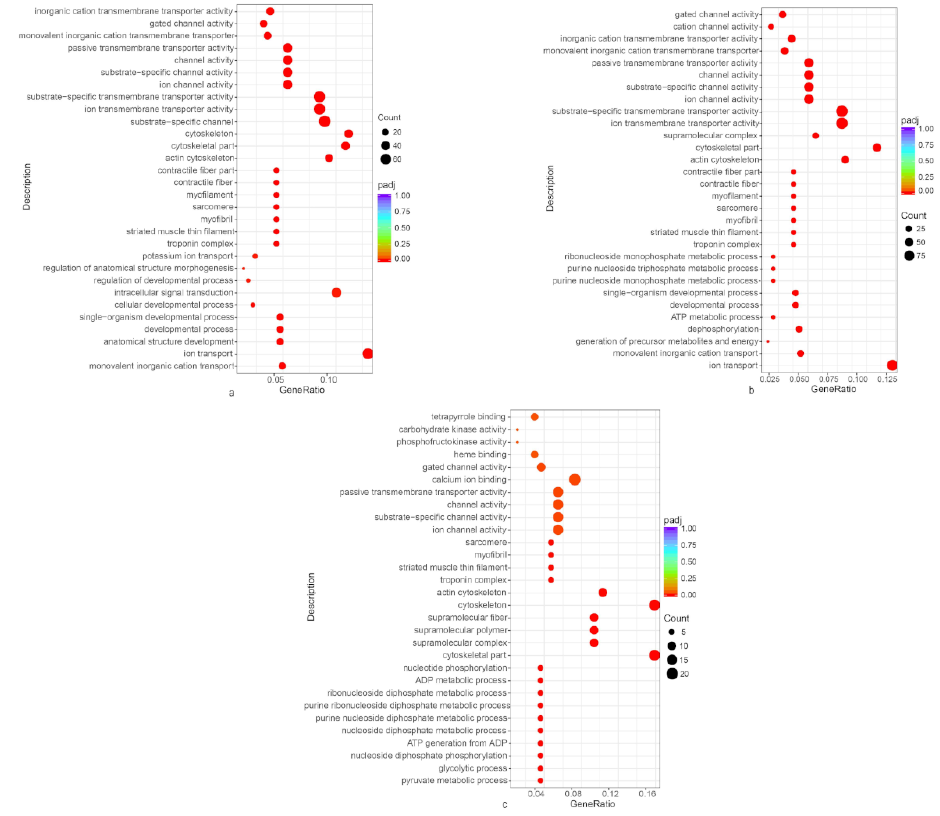
Figure 3. Gene Ontology (GO) function classification of the differentially expressed genes (DEGs) comparison between the groups (padj < 0.05). ( a ) Black-spotted skin vs. non-spotted skin; ( b ) Black- spotted skin vs. Caudal fin; ( c ) Caudal fin vs. non-spotted skin. The x-axis represents the number of genes, and the y-axis represents GO